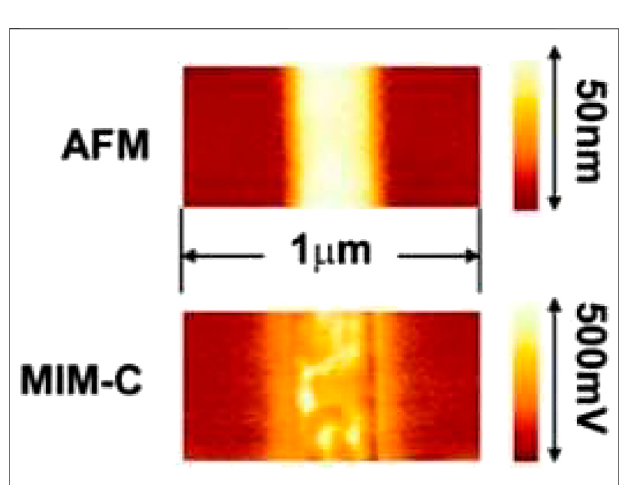
FIGURE10| SimultaneouslytakentopographyandMIM-Cimagesofan In 2 Se 3 nanoribbon. [72] Reproduced with permission from Nano Lett. 9, 3 (2009). Copyright 2009 American Chemical